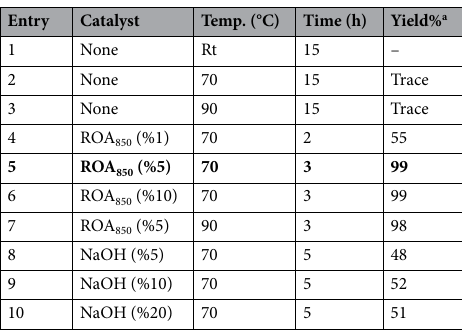
Table 3. Effect of catalyst, its loading, and temperature on the condensation reaction of compound 5a . a Isolated yield